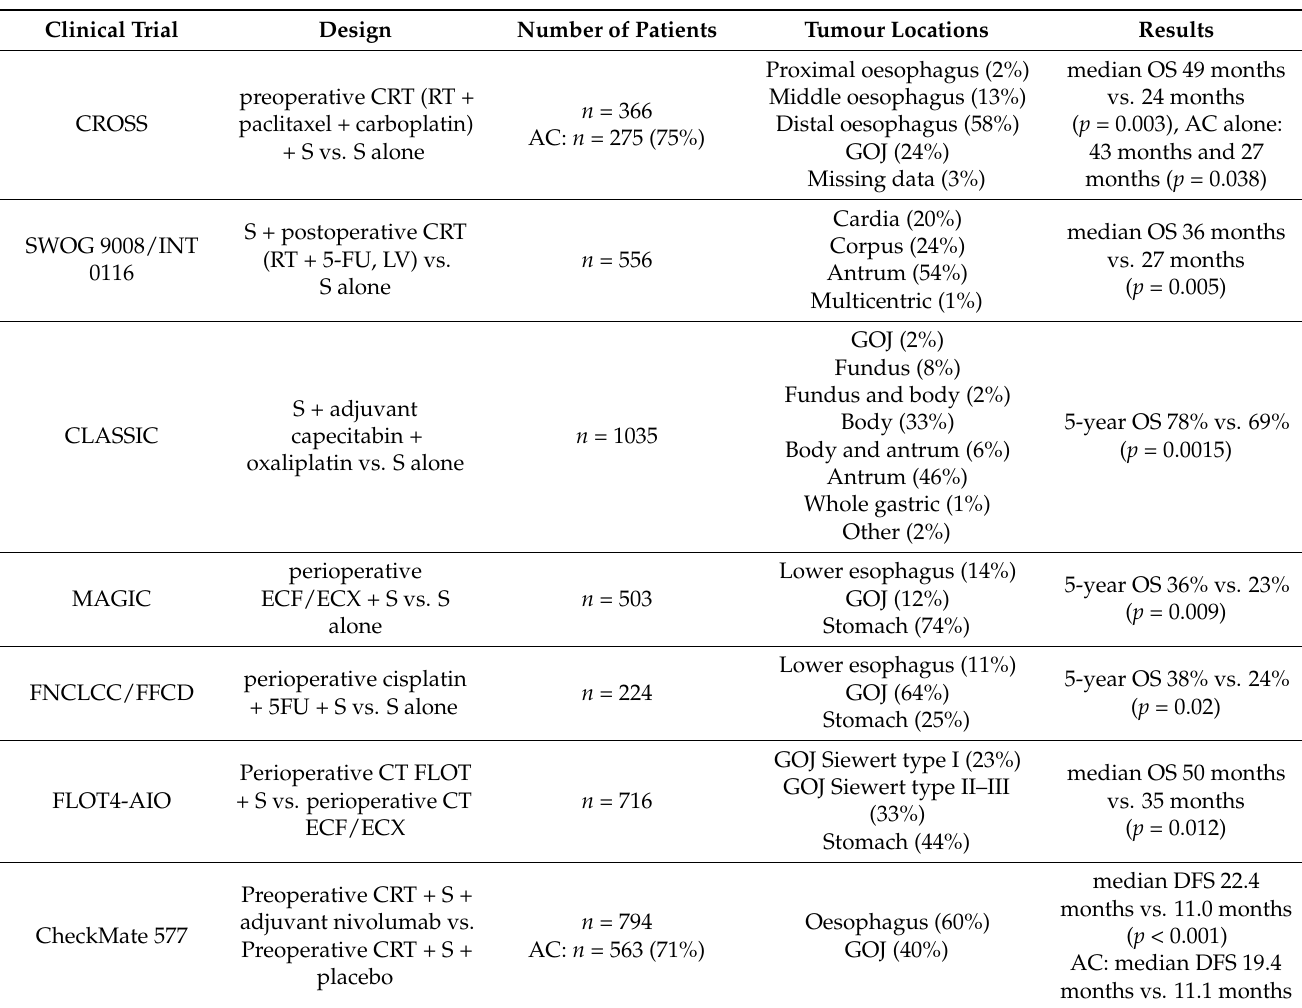
Table 1. List of the main randomised clinical trials influencing clinical practice in locally advanced oesophageal and gastro-oesophageal junction